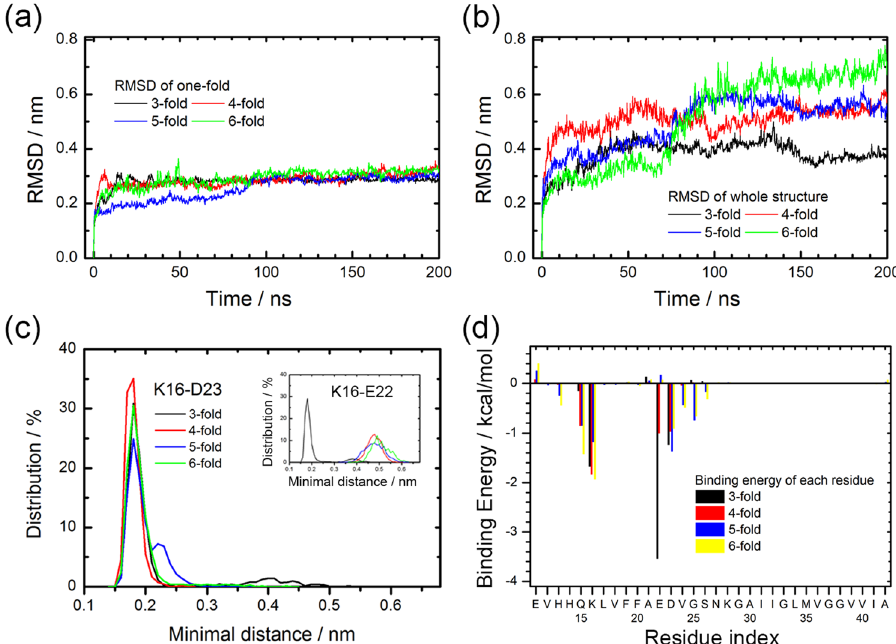
Figure 7. Conformation characteristics and binding energy of N-fold model. RMSD with respect to the start configuration as function of time for a single chain ( a ) and the whole model ( b ). The minimal distance between corresponding inter-chain residues K16 and D23, with the insert showing the distance between residues K16 and E22 (c) . Binding energy decomposition of each residue between different chains in N-fold models ( d ).